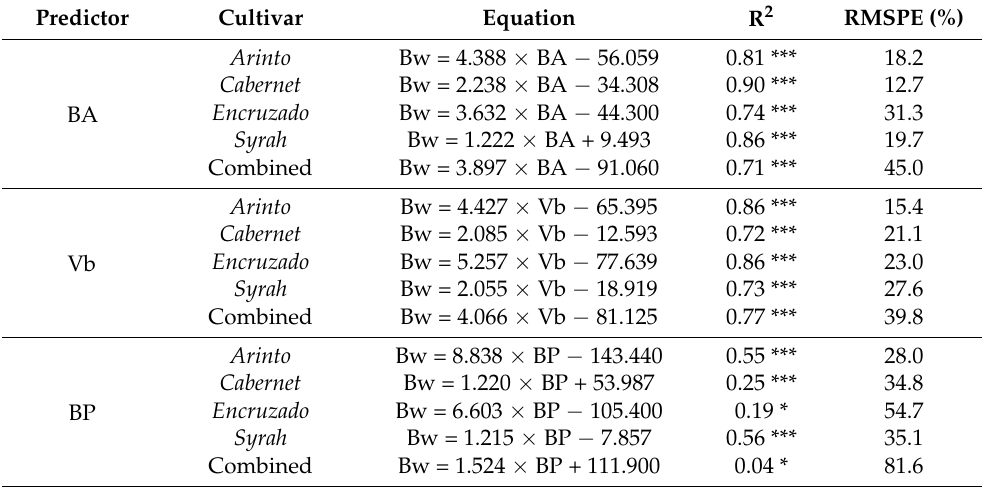
Table 3. Fitted models resulting from the linear regression between bunch weight (Bw; g; predictor) over bunch area (BA; cm 2 ), visible berry number (Vb), total berry number (Tb), and bunch perimeter (BP; cm), and respective statistical deviance measures for each of the four cultivars ( n = 30) and for the combined data ( n = 120) on the training